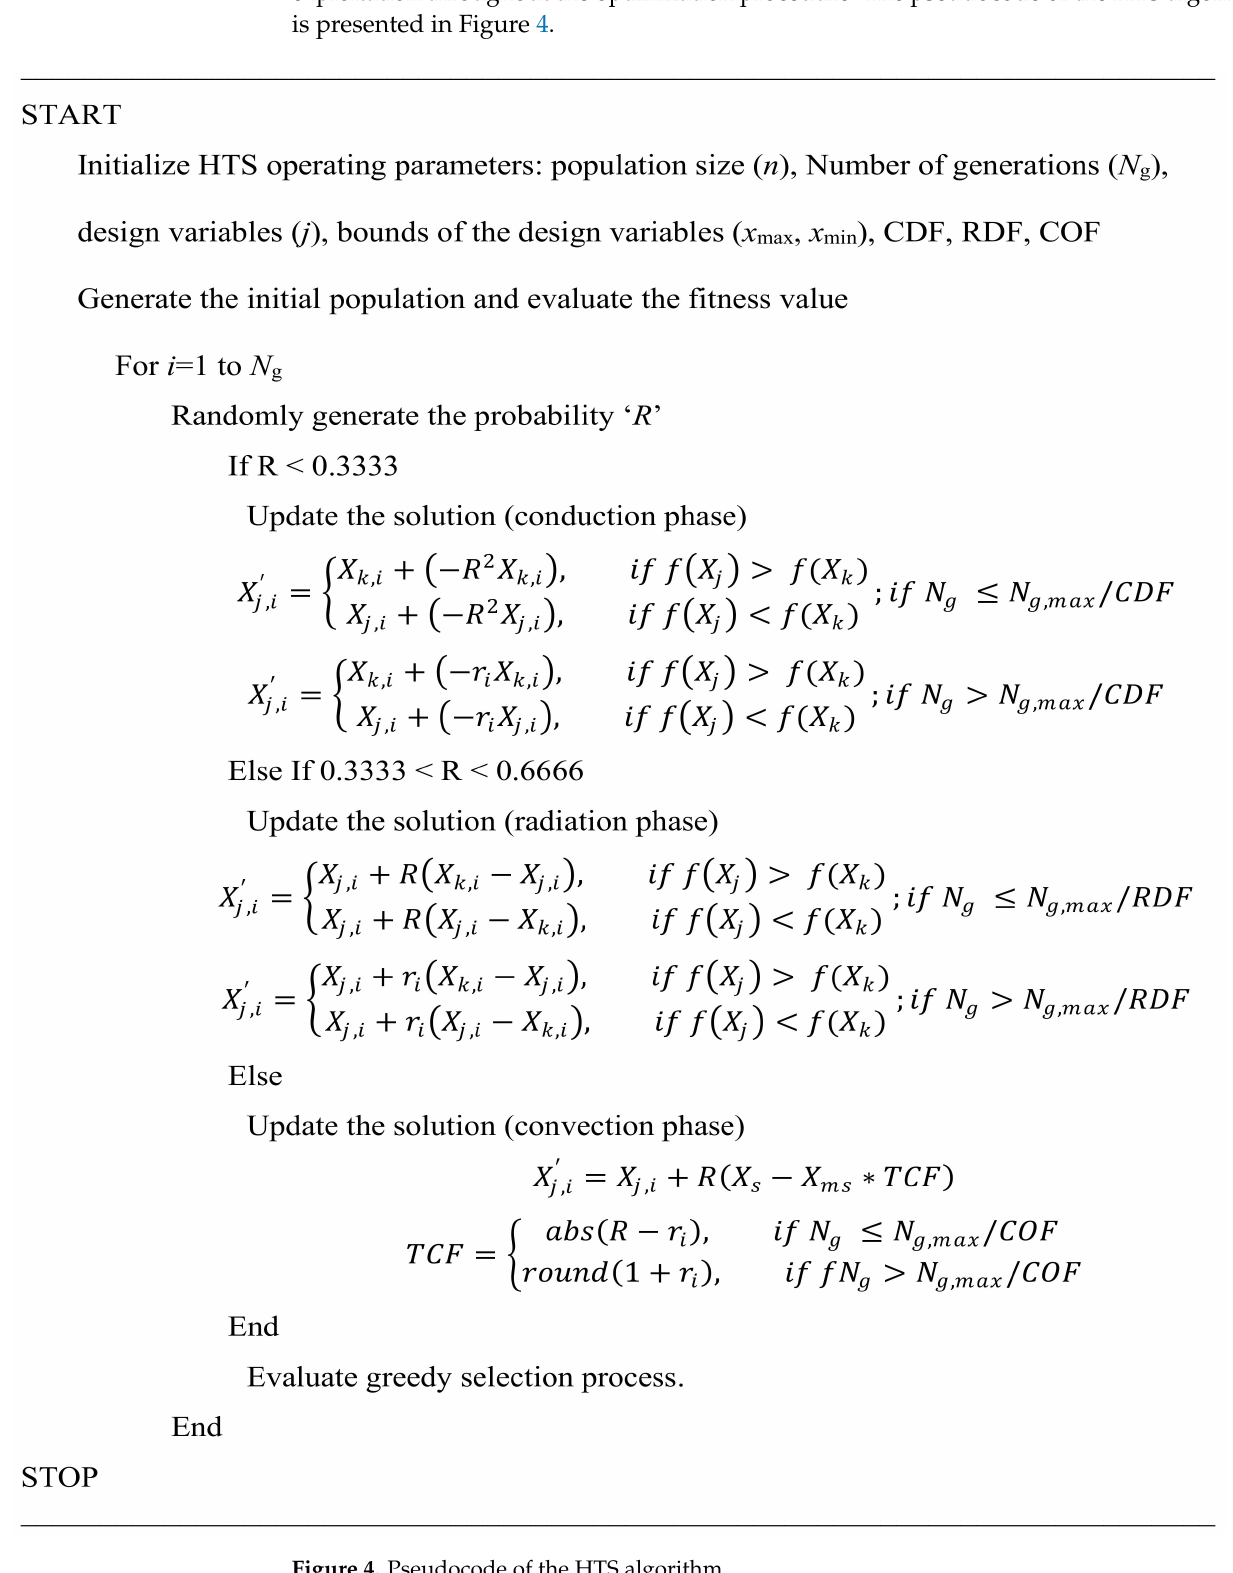
Figure 4. Pseudocode of the HTS